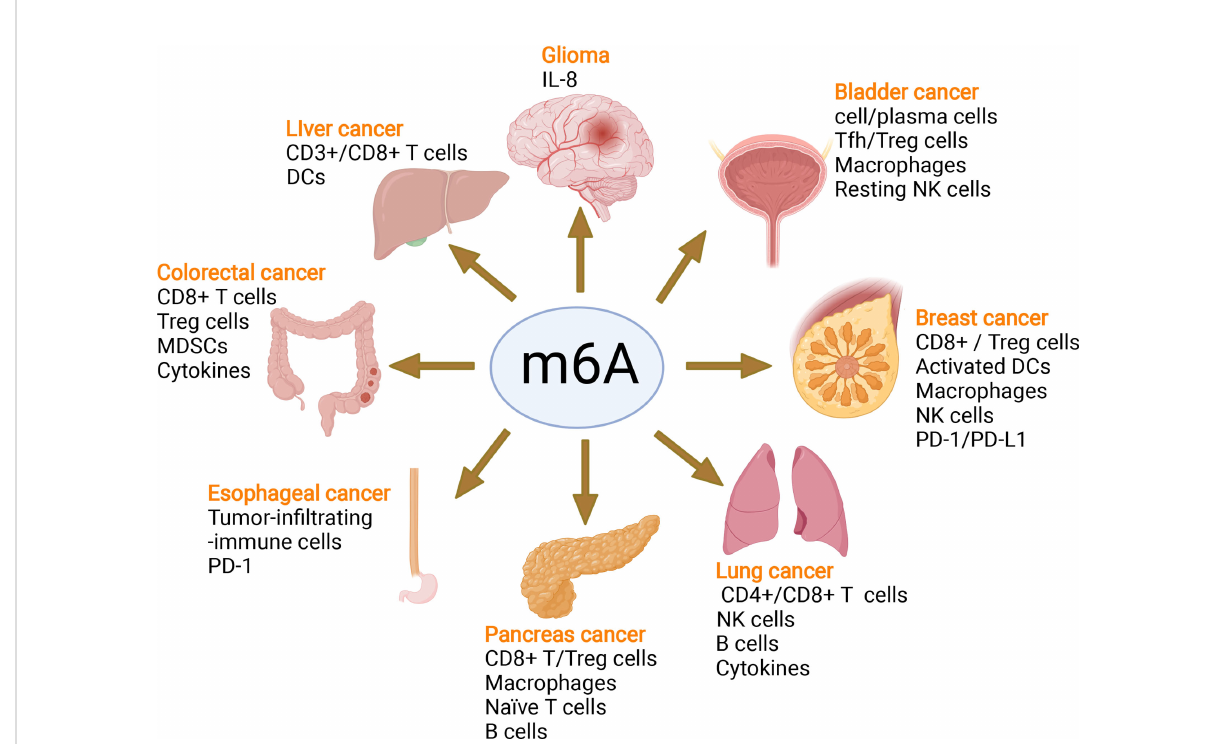
FIGURE 7 m6A modi fi es the tumor immune microenvironment and regulates tumor progression. m6A writers, erasers and readers regulate the tumor immune microenvironment in glioma, liver cancer, colorectal cancer, esophageal cancer, pancreatic cancer, lung cancer, breast cancer, and bladder cancer by controlling different immune cells and the PD-1/PD-L1 immune checkpoint mediating the ef fi cacy of immune